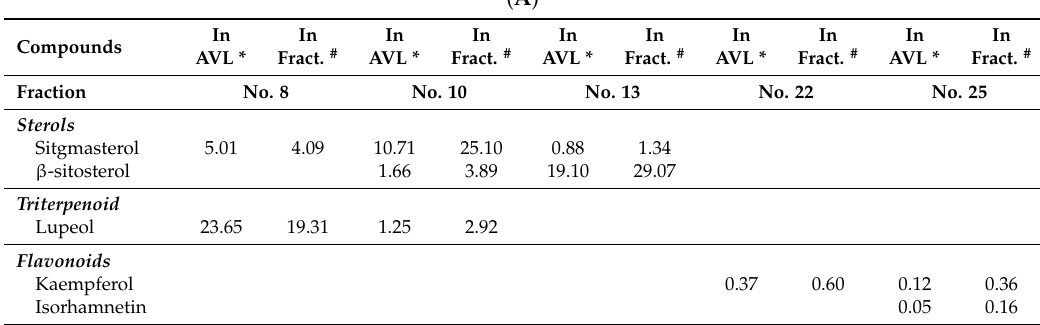
Table 2. ( A ) Sterol, flavonoid, and triterpenoid composition in the ethanolic extracts of AVL leaves and fractions quantified by UPLC; ( B ) Mass spectral data of the identified sterols, flavonoids, and triterpenoids in AVL leaves; ( C ) NMR spectral data of the identified sterols, flavonoids, and triterpenoids in ethanolic extracts from AV